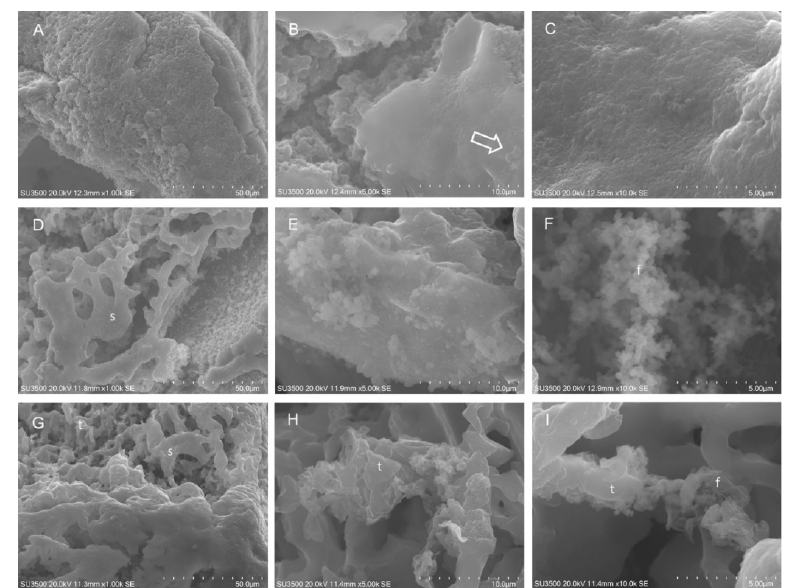
Figure 3. SEM analysis on S. aureus ATCC 25923. Untreated S. aureus 25923: ( A ) SEM, 1000×.